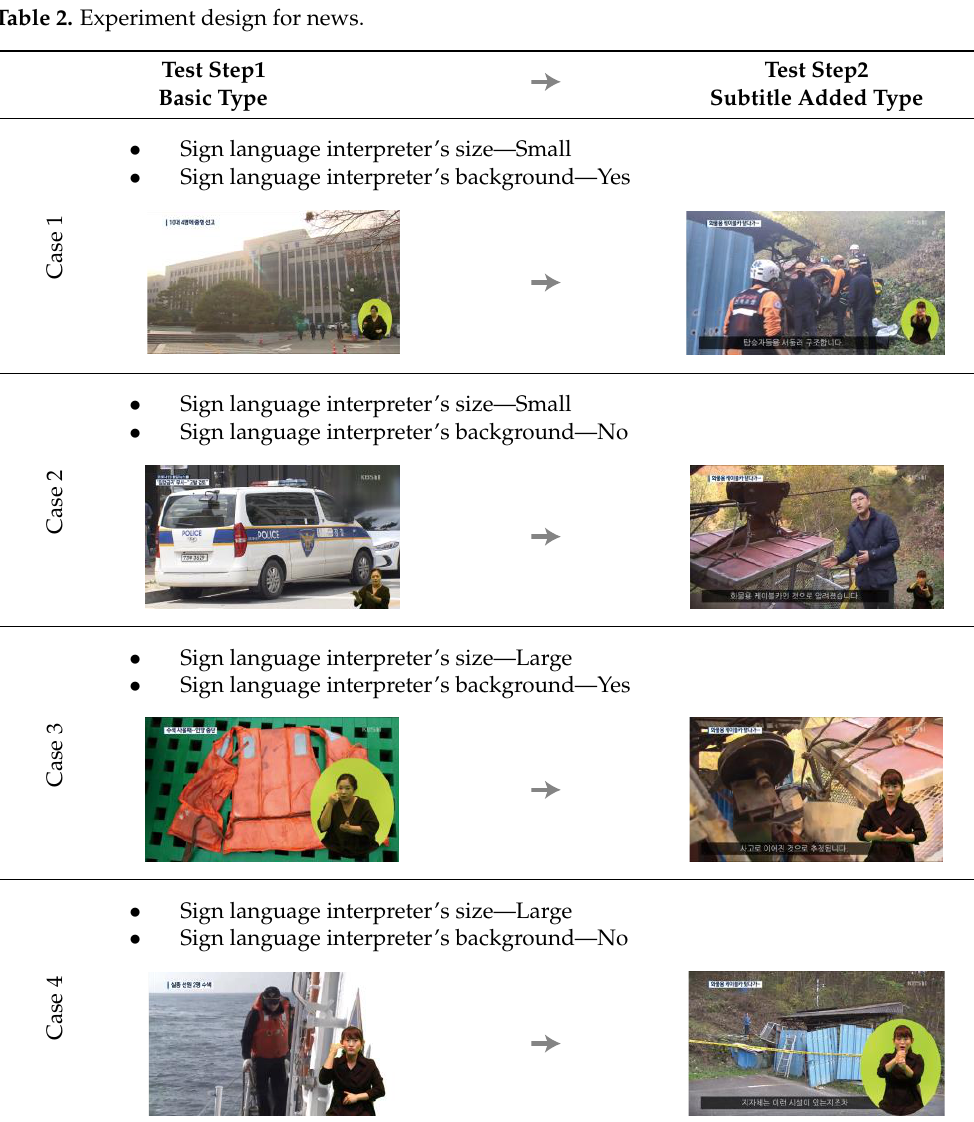
Table 2. Experiment design for news.